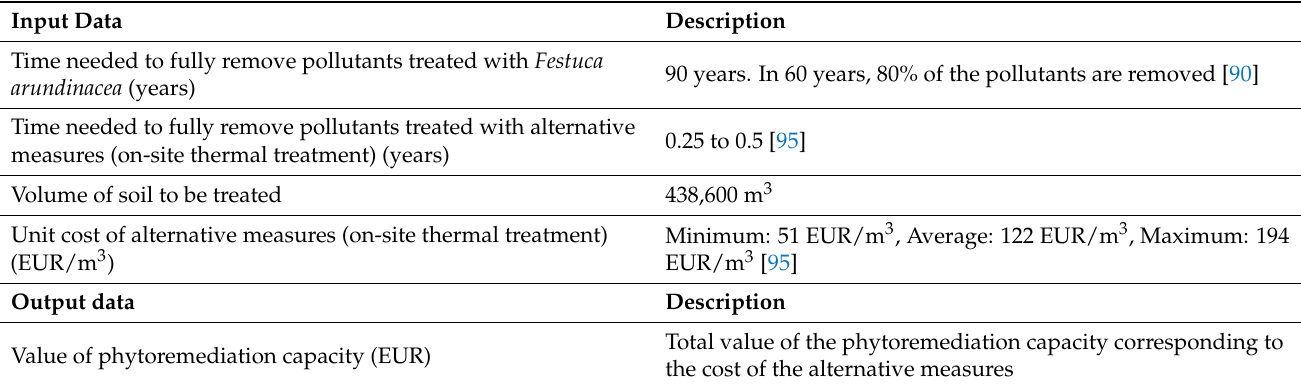
Table 4. Input and output data for the assessment and evaluation of phytoremediation